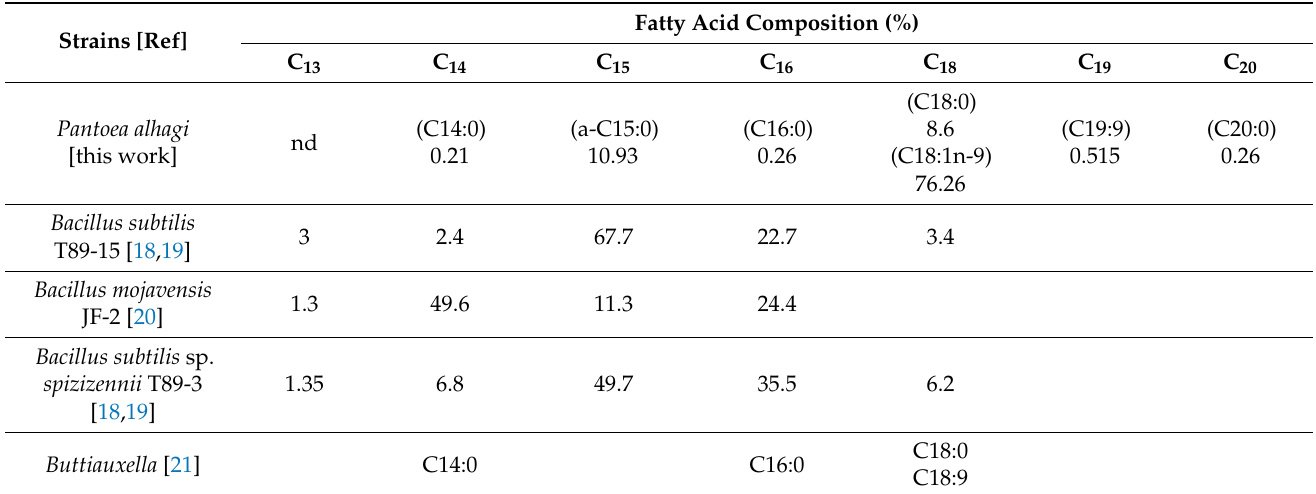
Table 3. Comparison of fatty acid ratios of different bacterial biosurfactants.